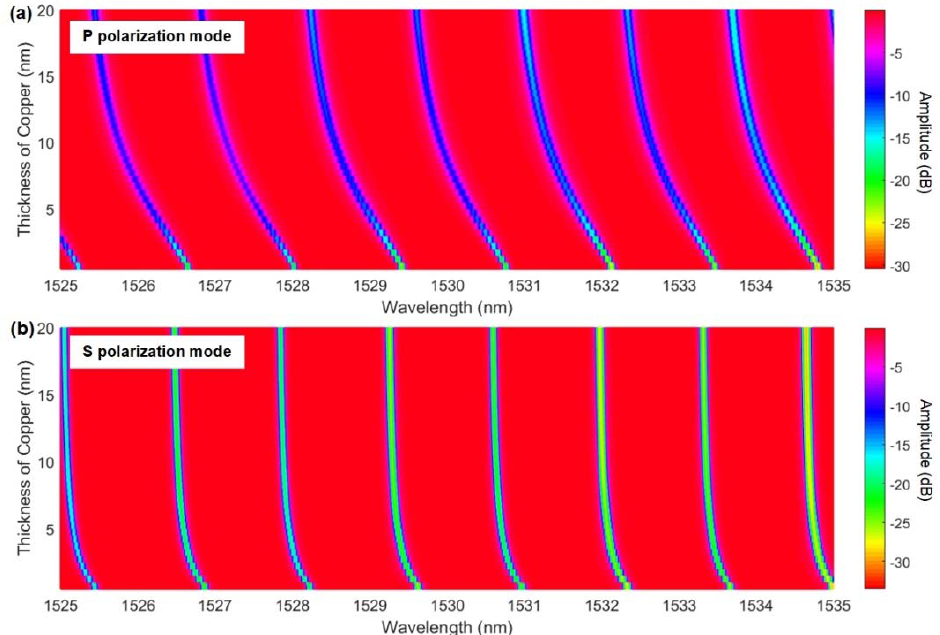
Figure 5. Simulation of the evolution of ( a ) P-polarized and ( b ) S-polarized resonances as a function of copper thickness, using the ‘bulk’ permittivity of copper at these wavelengths.